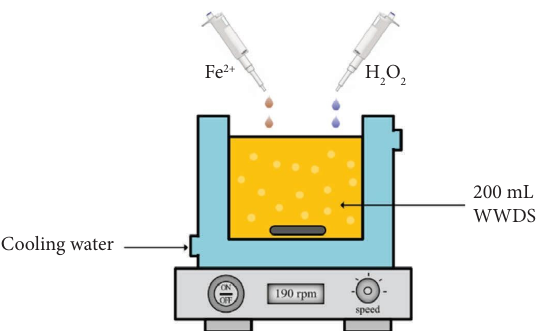
Figure 1: Diagram of the experimental setup to carry out the tests of the Fenton